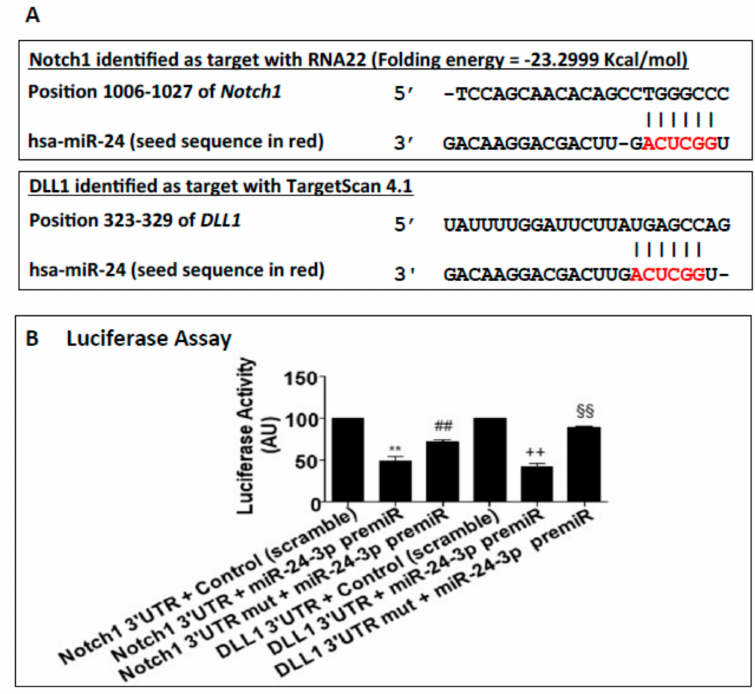
Figure 1. Target-gene prediction and primers sequences: ( A ) Analysis of the seed sequence of miR-24-3p (red letters) in the 3 (cid:48) -UTR of Notch1 and Dll1 with RNA22 software and Targetscan 4.1. Gray part: binding strength. ( B ) To validate the relation between miR-24-3p and the predicted targets, the luciferase assay was performed. HEK293 cells were transfected with pre-miR-24-3p or control and the reporter gene for Notch1 3 (cid:48) -UTR or Dll1 3 (cid:48) -UTR or their respective mutants. Experiments were performed in triplicate and repeated three times. Values are means ± SEM. ** p < 0.001 vs. Notch1 3 (cid:48) -UTR + control; # # p < 0.01 vs. Notch1 3 (cid:48) -UTR + pre-miR-24; ++ p < 0.05 vs. Dll1 3 (cid:48) -UTR + control; $$ p < 0.01 vs. Dll1 3 (cid:48) -UTR +